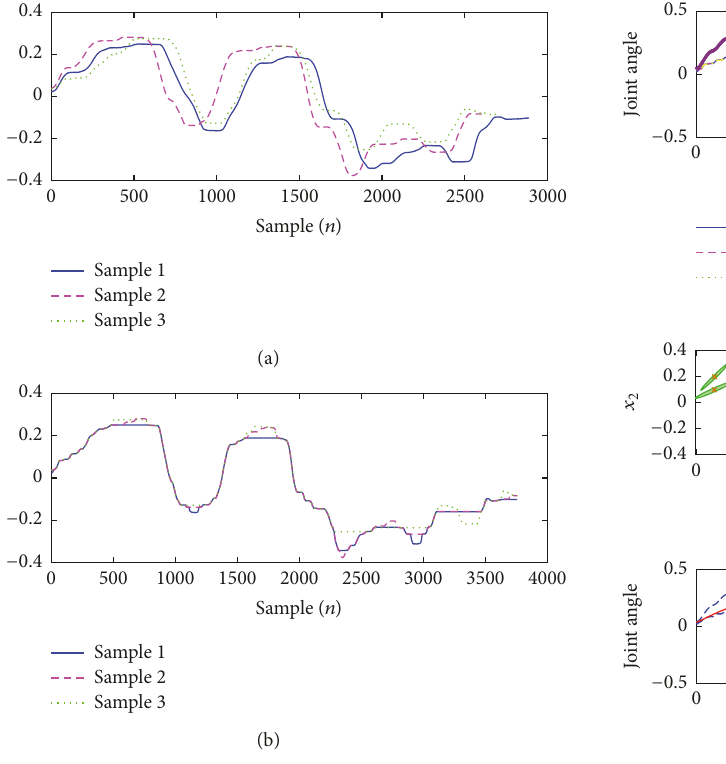
Figure 7: (a) Three original samples of the joint angle 𝑆0 . (b) The processed samples after DTW time alignment.